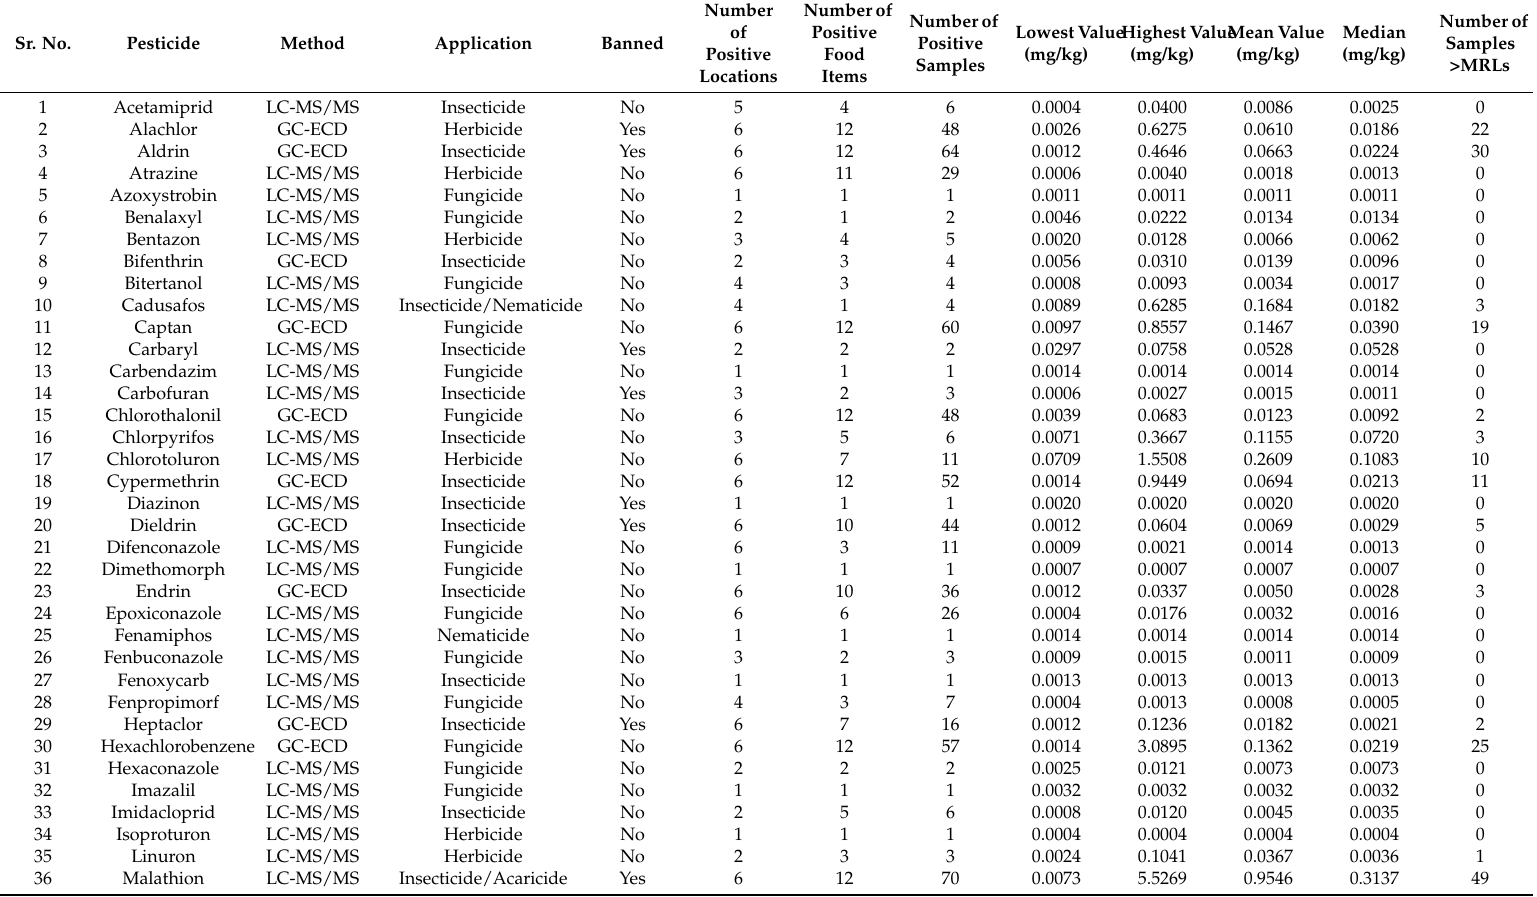
Table 3. Characteristics of the 62 pesticides analyzed by LC-MS/MS and GC-ECD (gas chromatography-electron capture detection) in 12 food items from the western highlands of